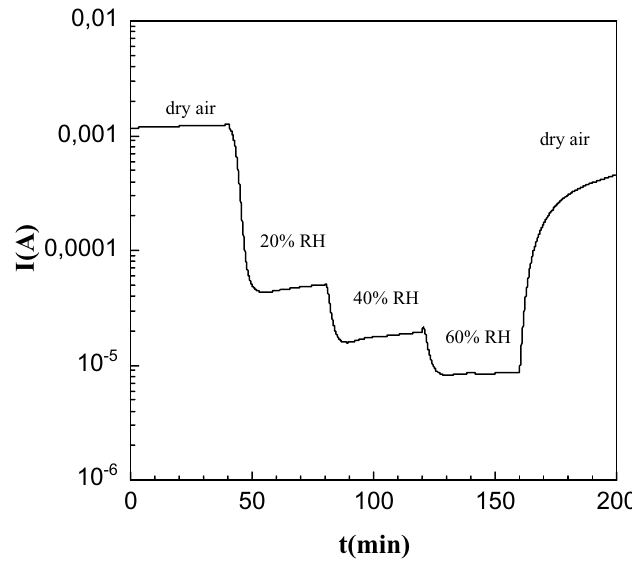
Figure 5. Dynamic electrical response of the device towards stepwise changes in relative humidity at RT.